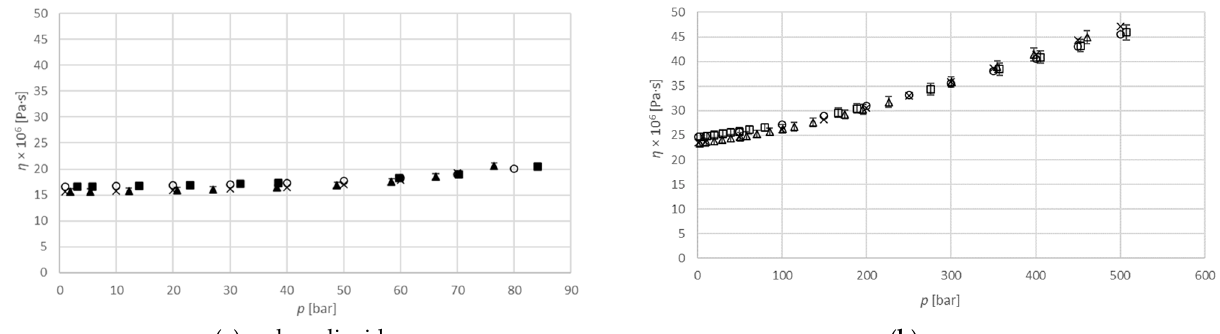
Figure 4. The viscosity of pure gas as a function of pressure in comparison to literature data: , measured data at 313.15 K; , measured data at 333.15 K; X, pure gas at 313.15 K [16]; , pure gas at 333.15 K [16].